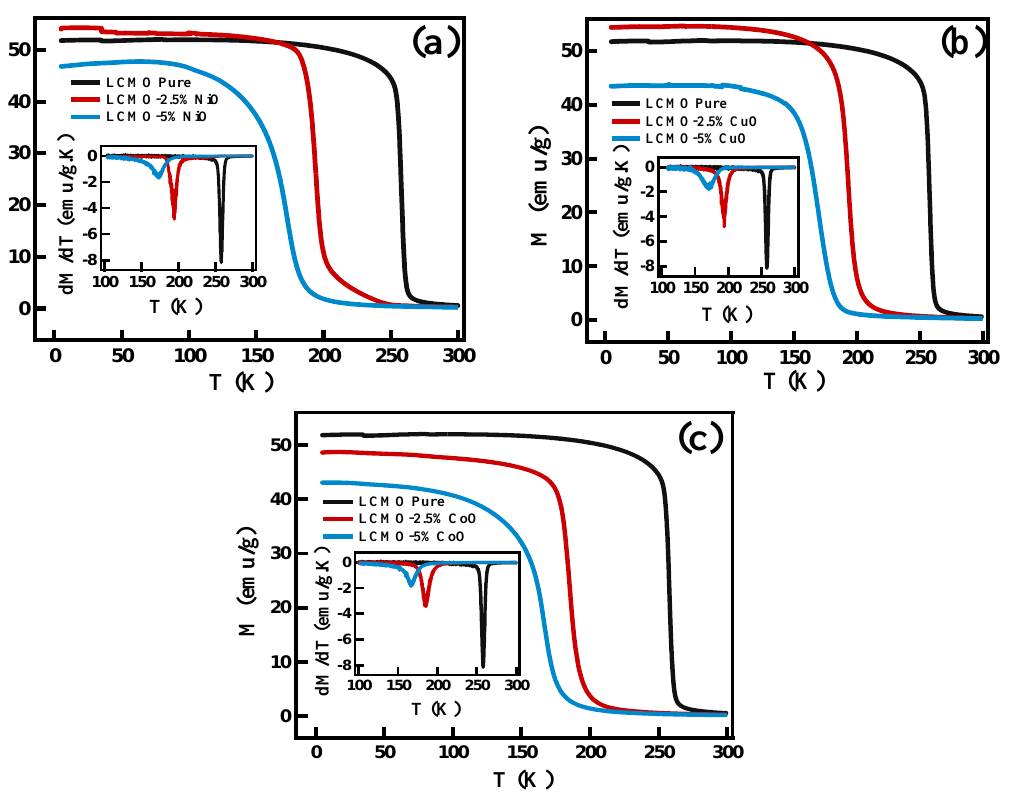
Figure 3. Field Cooled (FC) curve of LCMO-MO composite samples measured in an externally applied field of 1kOe ( a ) LMCO- x % NiO, ( b ) LCMO- x % CuO, and ( c ) LCMO- x %CoO. Insets show dM/dT vs. T plot. Table 3. The magnetic phase transition temperature of LCMO – MO composite samples.